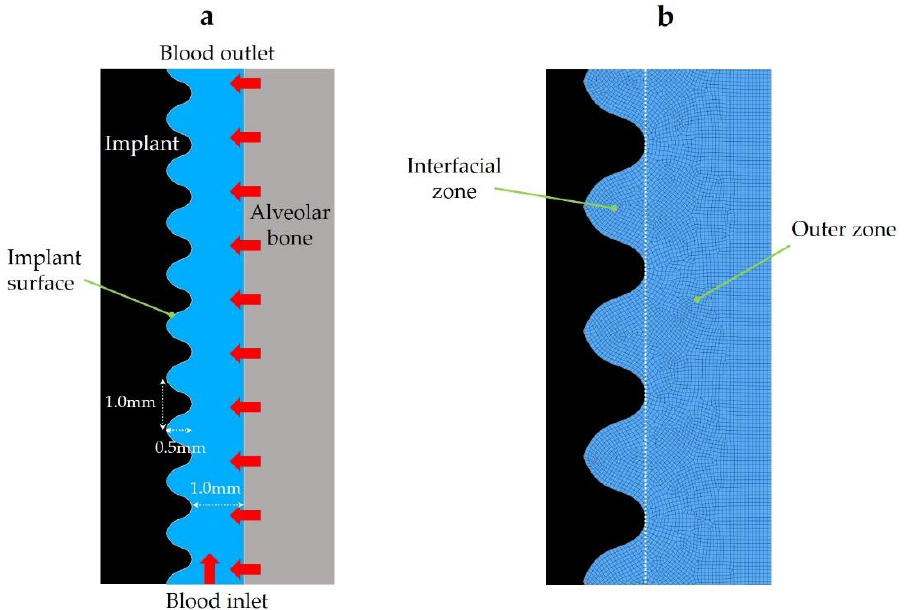
Figure 1. ( a ) Geometrical model and ( b ) computational mesh. The red arrows show the direction of the whole blood flow at the inlets.